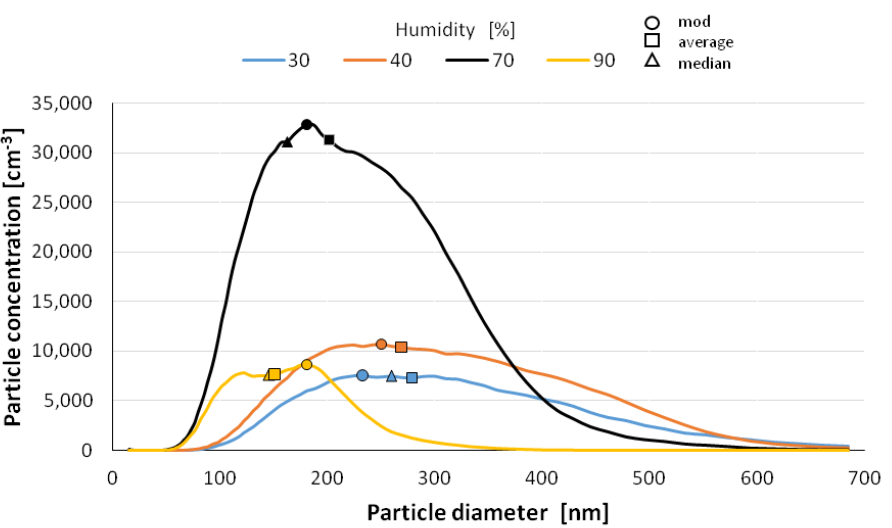
Figure 9. Size distribution of superfine particles 10.5 min after atomization.